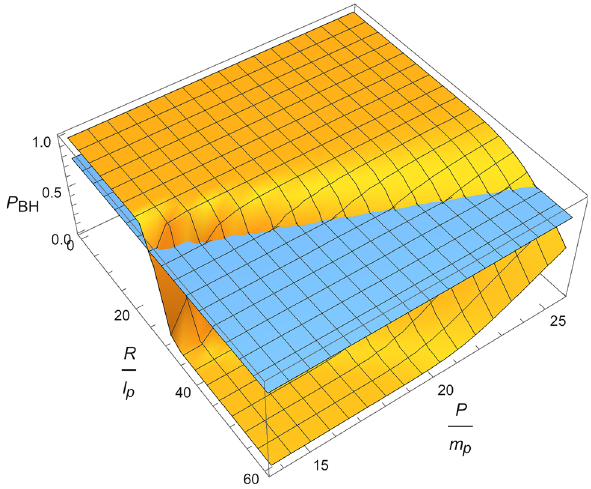
Fig. 11 Probability for a shell collapsing towards a central mass m to form a black hole as a function of the radius of the central mass R and the total energy of the system E (in Planck units). The blue plane delimits the region where the probability P BH > 0 . 8